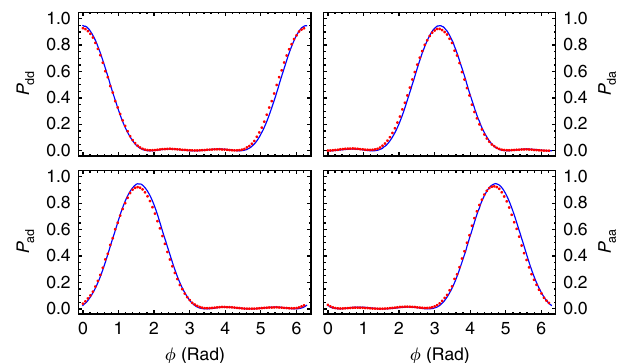
Fig. 5 Probability distribution of measurement outcomes. The probabilities of obtaining the four possible f dd ; ad ; da ; aa g measurement outcomes which correspond to four possible ϕ values, for each phase value shown est in Fig. 4. The variance V ϕ is minimised for those ϕ values when one of the H probabilities is maximum. Dots are experimental values and lines are numerical simulations that use the experimentally generated ρ as input. exp Error bars, representing the statistical uncertainty due to the fi nite number of measurement sets, are smaller than the dot size